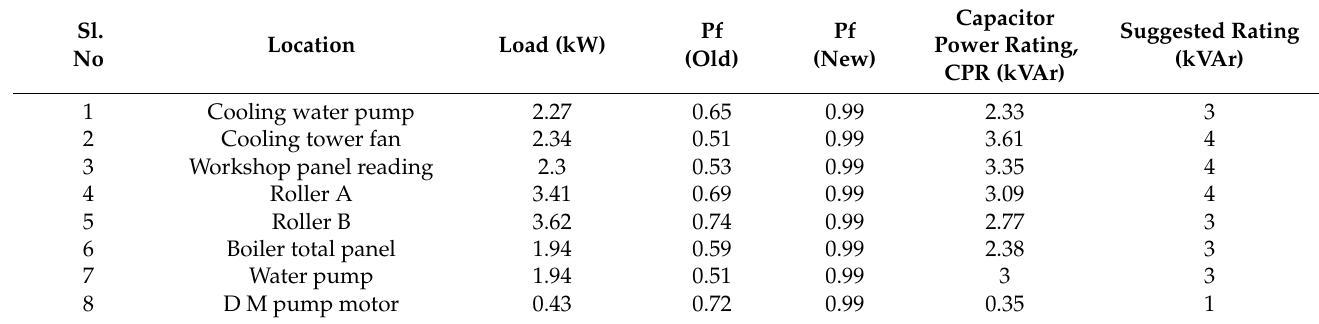
Table 14. Recommended rating of capacitors to improve pf in panels.